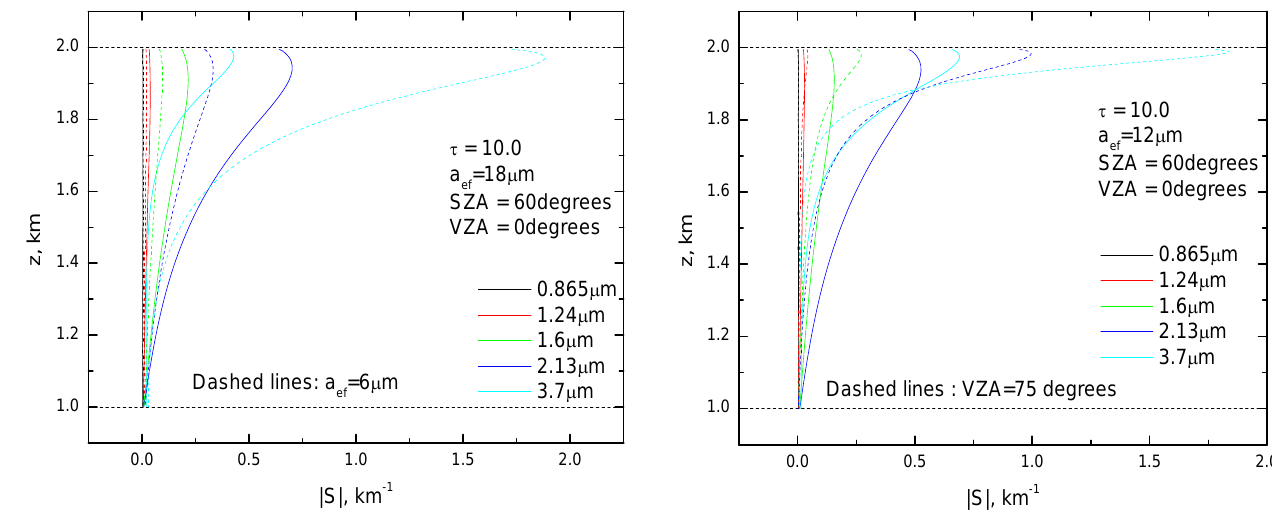
Fig. 2. The same as in Fig. 1c except at ER=6 and 18µm.